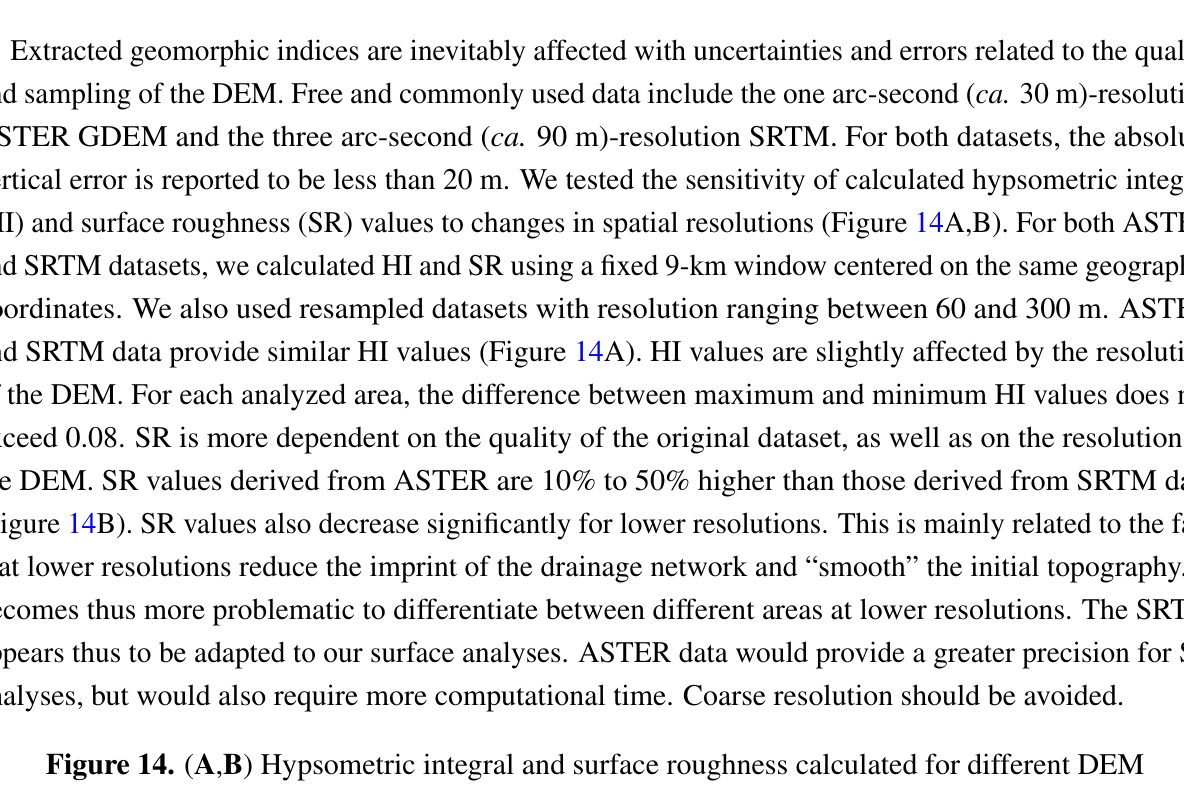
Figure 14. ( A , B ) Hypsometric integral and surface roughness calculated for different DEM resolutions; ( C , D ) hypsometric integral and surface roughness calculated using different windows (in